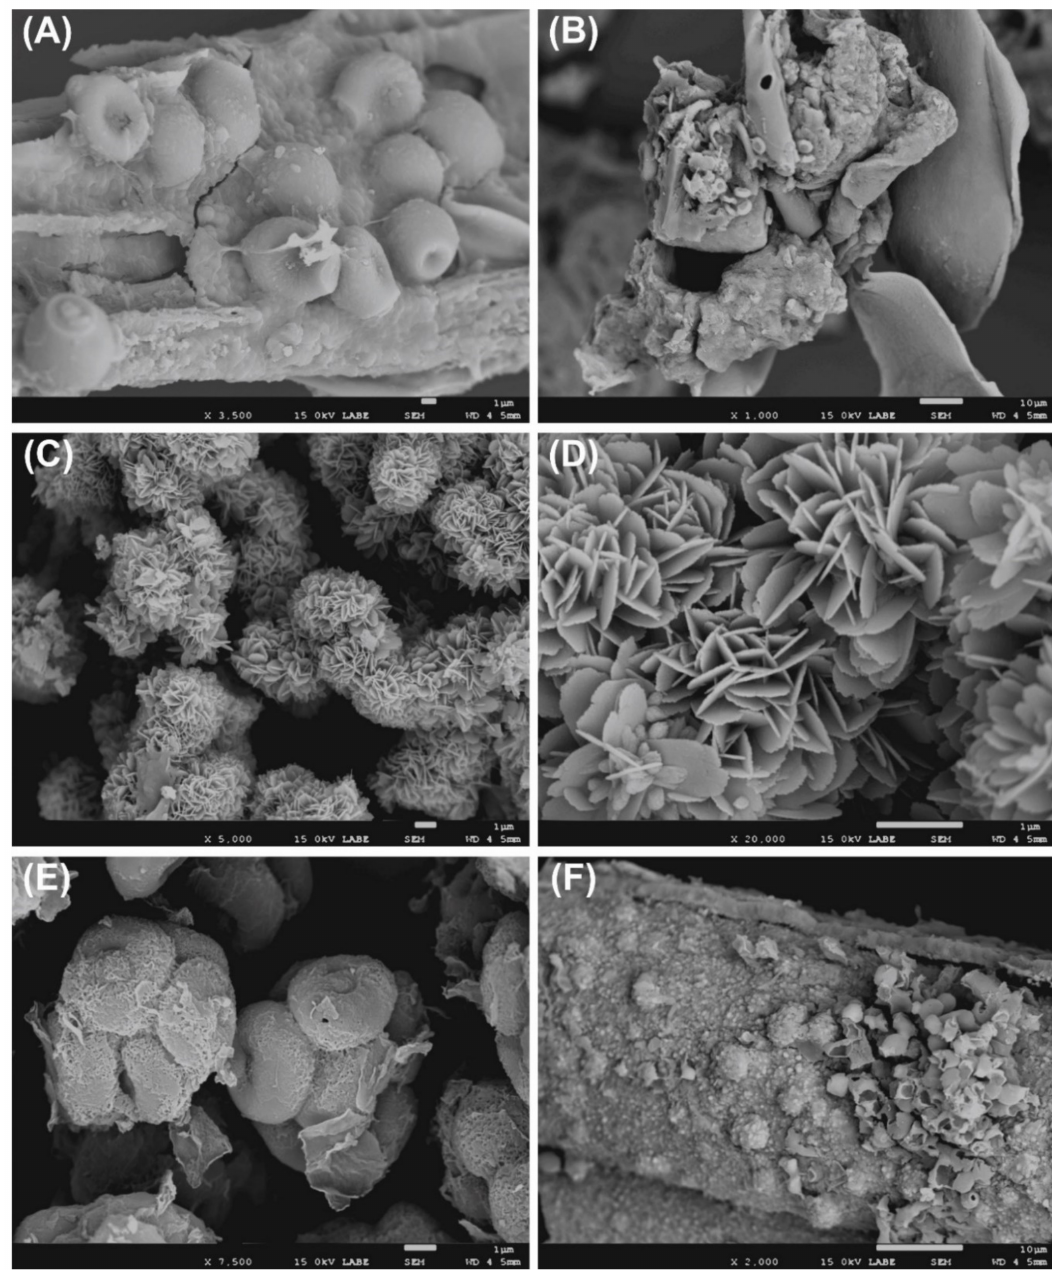
Figure2. Scanningelectron microscope (SEM)observationof nitrocellulose membranes. ( A )Conidia, ( B ) fungi colonizing insect remains, ( C , D ) biogenic crystals and their morphological details, ( E ) ascospores, ( F ) presence of fungal conidia and